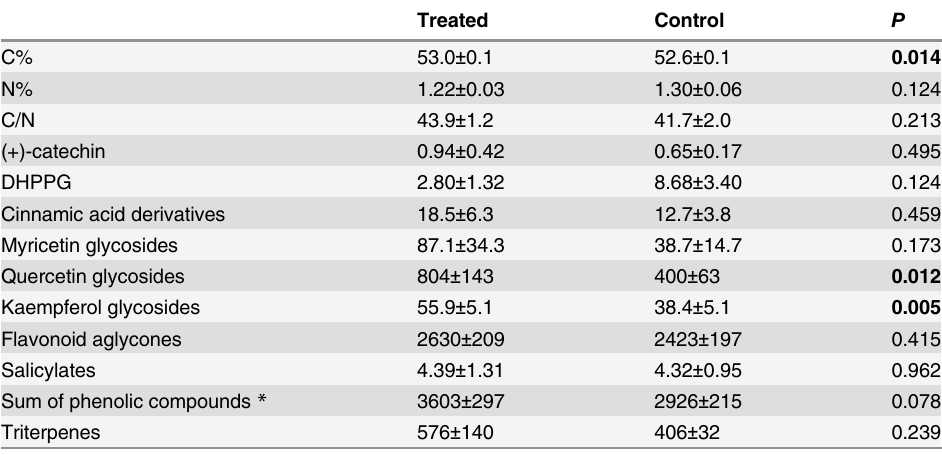
Table 3. Means ( ± SE) of the attributes of leaf litter chemistry (the concentrations of secondary compounds are relative, i.e. given as peak area g − 1 dry litter material) in the insecticide treated and control saplings and the statistical signi fi cance of the difference between the means (tested using a pairwise t -test).